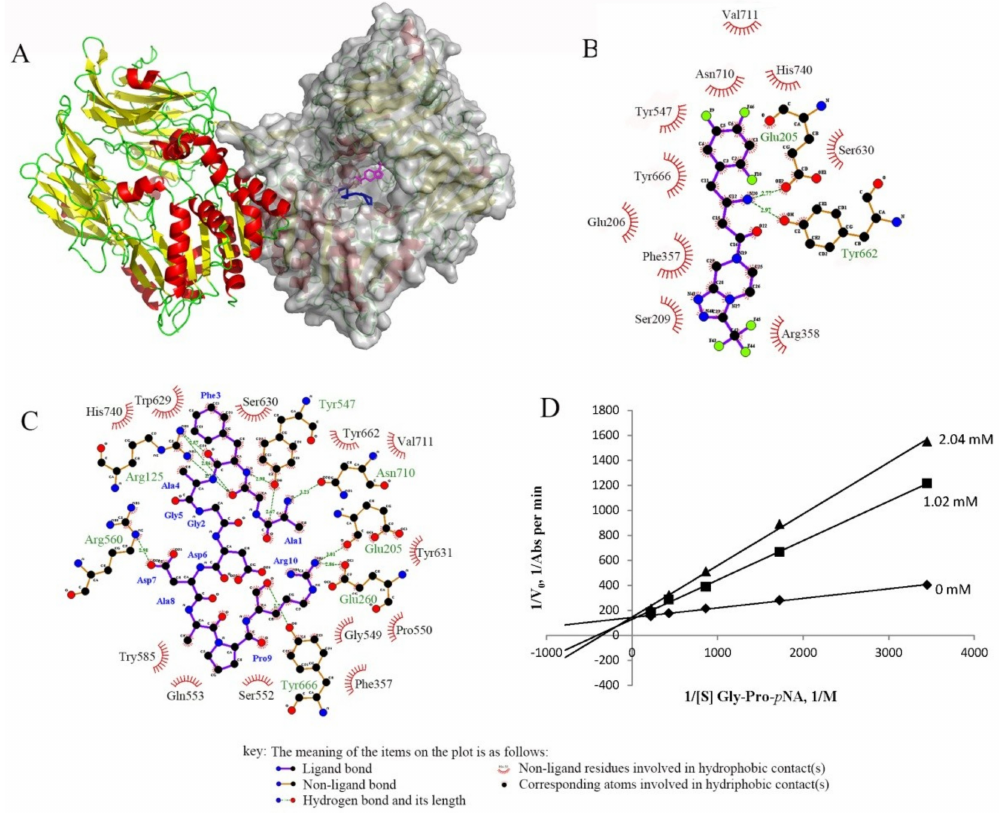
Figure 6. ( A ) Molecular modeling of the interaction between DPP-IV (1X70) and its ligands: sitagliptin (magenta) and peptide II (blue). Chain B is shown as a surface in gray. The profiles of the binding sites of DPP-IV with ( B ) sitagliptin and ( C ) peptide II produced by LigPlot+ show the detailed interaction. ( D ) Lineweaver–Burk plot for DPP-IV activity in the absence and presence of peptide II with different inhibitory concentrations (0, 1.02, and 2.04